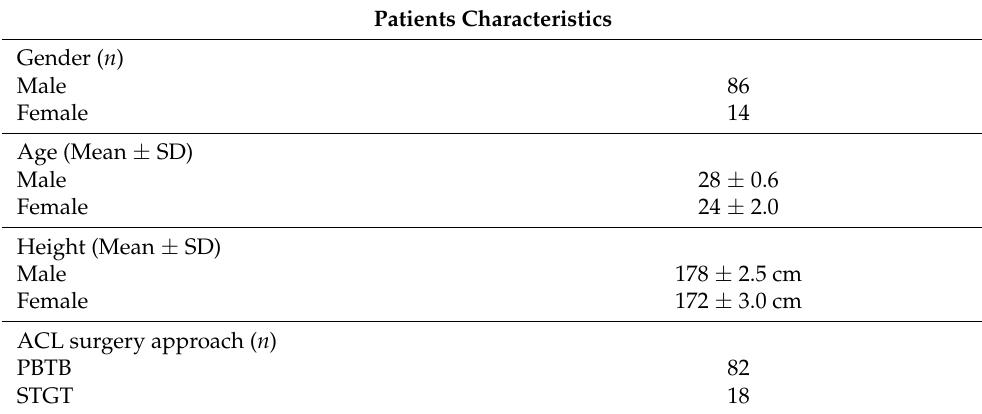
Table 1. Patient’s Characteristics. PBTB: Patellar Bone-Tendon-Bone; STGT: semitendinosus– gracilis graft.